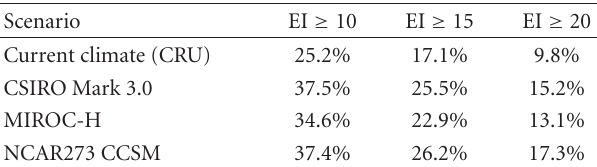
Table 6: E ff ect of changes in precipitation (expressed as a percentage of total geographic area) from current values on Ecoclimatic Indices for Sitona lineatus across North America for CRU (current climate) and general circulation model (CSIRO MARK 3.0, MIROC-H, NCAR273 CCSM)